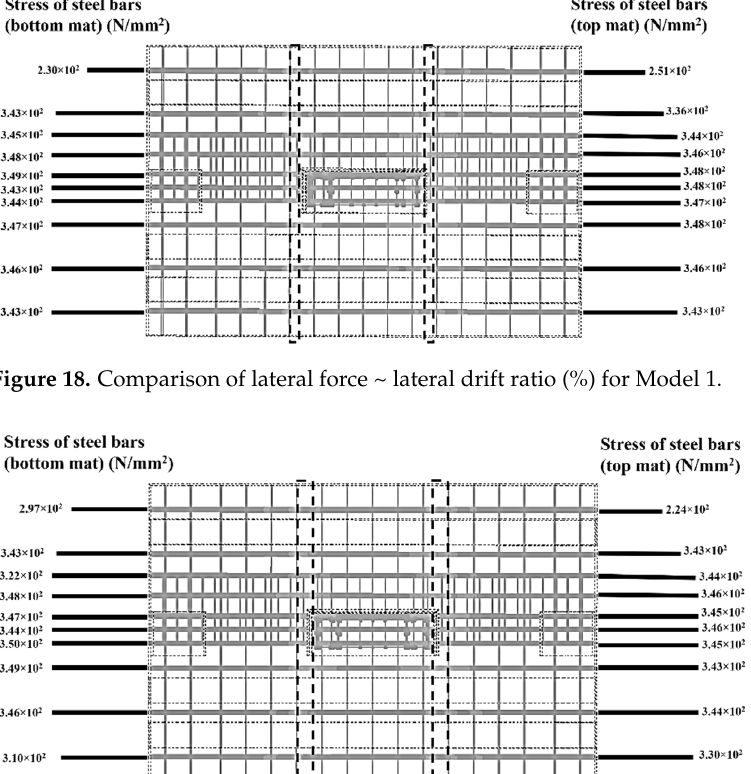
Figure 20. Lateral strength versus drift ratio curves for slab span length models.